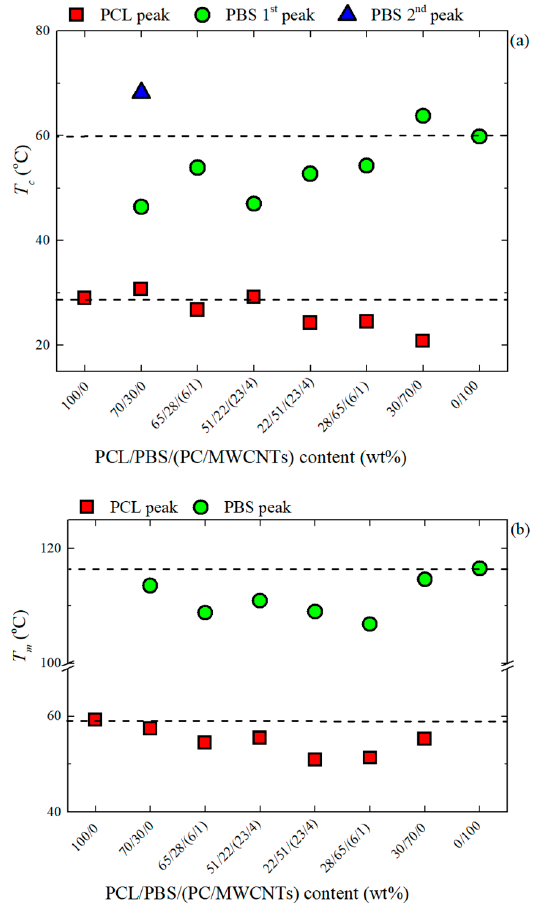
Figure 4. ( a ) Crystallization and ( b ) second heating melting temperatures for the PCL/PBS blends and the PCL/PBS/(PC/MWCNTs) nanocomposites. In Figure 4(b), the changes in T m are most significant when the masterbatch is added, because of the partial miscibility between the PCL-rich and PC-rich phases, as well as the PBS-rich and PC-rich